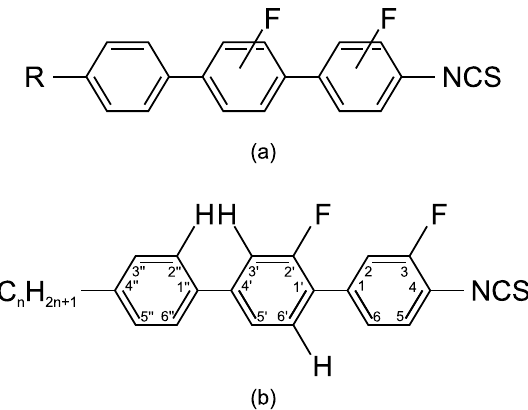
Figure 1. ( a ) General formula of mixture 1929. ( b ) The chemical formula of prepared isothiocyanatoterphenyls 54 .